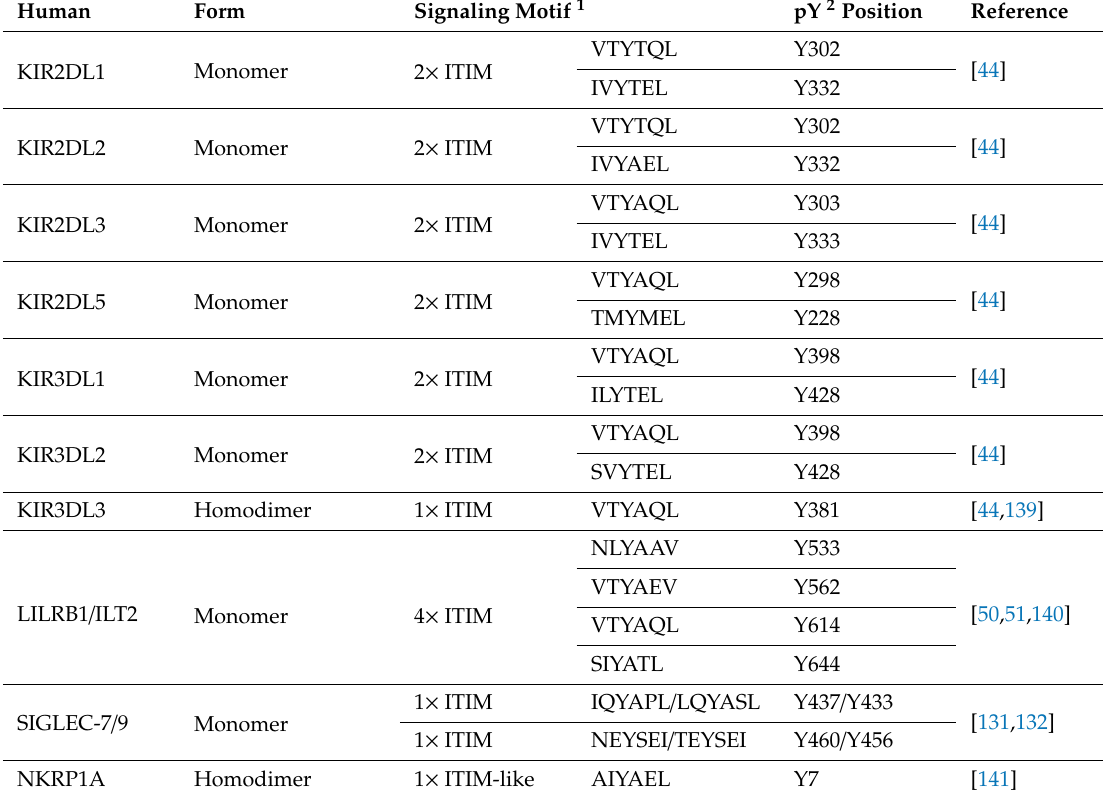
Table 3. Inhibitory NK cell receptors and their signaling